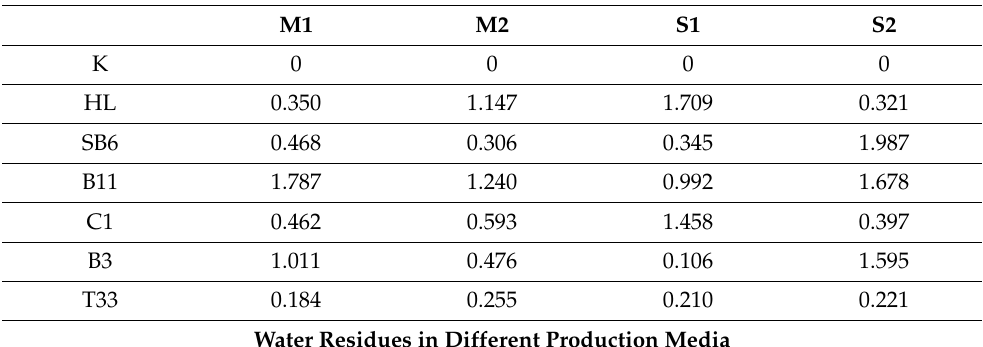
Table 4. Dry matter extracted with organic solvent (including surfactants) and residue in the aqueous phase in g/L. Compilation of MGP (M1, M2) and Saunders (S1, S2) media. Organic Solvent Extract in Different Production Media M1 M2 S1 S2 K 0 0 0 0